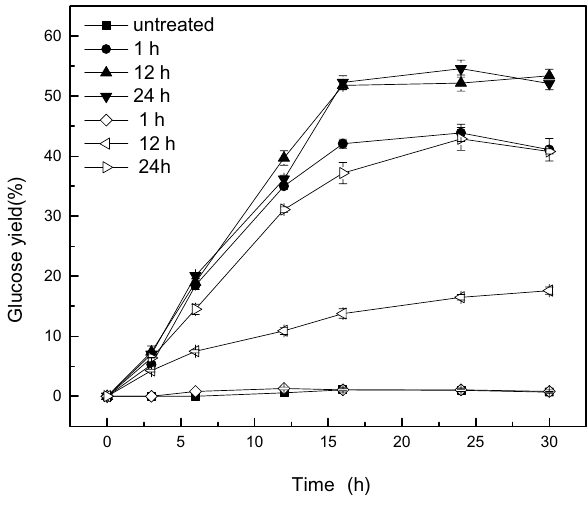
Fig. 5 Glucose yield from MCC pretreated for different times with Emim·OAc (closed symbols) and with ChCl·formic acid (open sym- bols). Reaction conditions: 0.05 g MCC, 0.1 g solid acid catalyst and 4 mL deionized water, 363 K